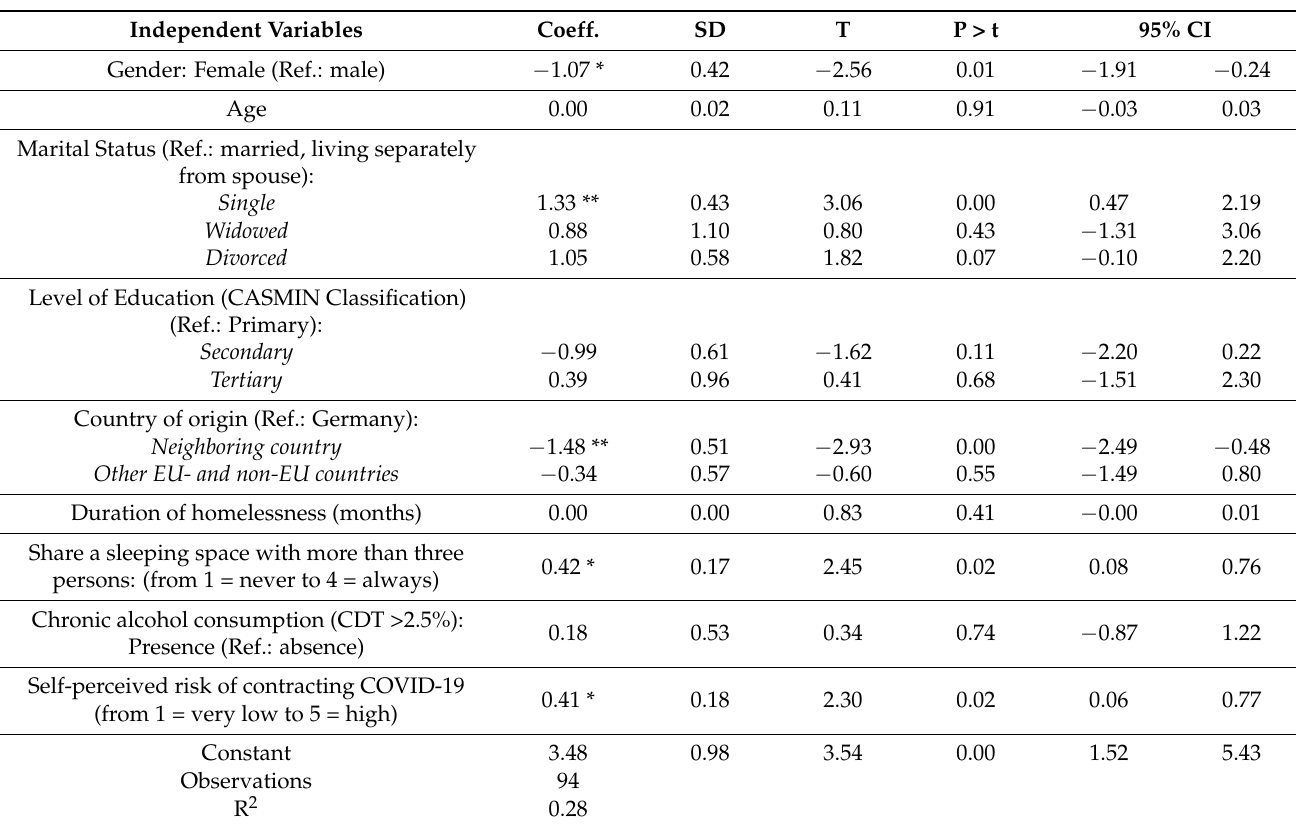
Table 2. Determinants of loneliness among homeless individuals during the COVID-19 pandemic: Findings of multiple linear regressions. Independent Variables